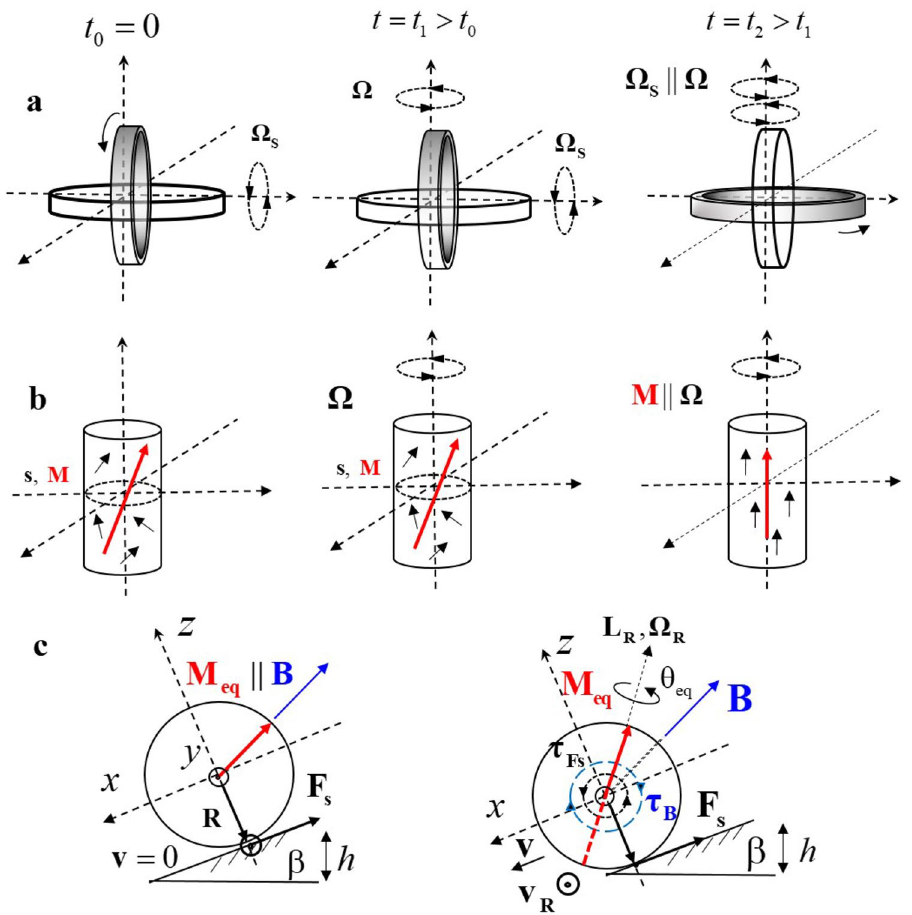
Figure 1. Gyroscopic, gyromagnetic and spin revolution effects. ( a ) Schematic representation of a mechanical gyroscope, which can be controlled by an external rotation (cid:31) to align the spinning axis (cid:31) s with (cid:31) . ( b ) Schematic representation of a gyromagnetic effect, in which the magnetization can be controlled by external rotation (cid:31) to align the magnetization M with (cid:31) . ( c ) Schematic side view of a spin revolution effect. Initially, the magnetized sphere is at rest and M || B . When the sphere starts to roll down an incline, the magnetization departs from its initial orientation, relaxes to a direction ensuring minimal total torque about rolling axis T c.m. → min , and starts to revolve with (cid:31) R . Vectors are represented by bold letters for clarity. Reprinted with permission from 11